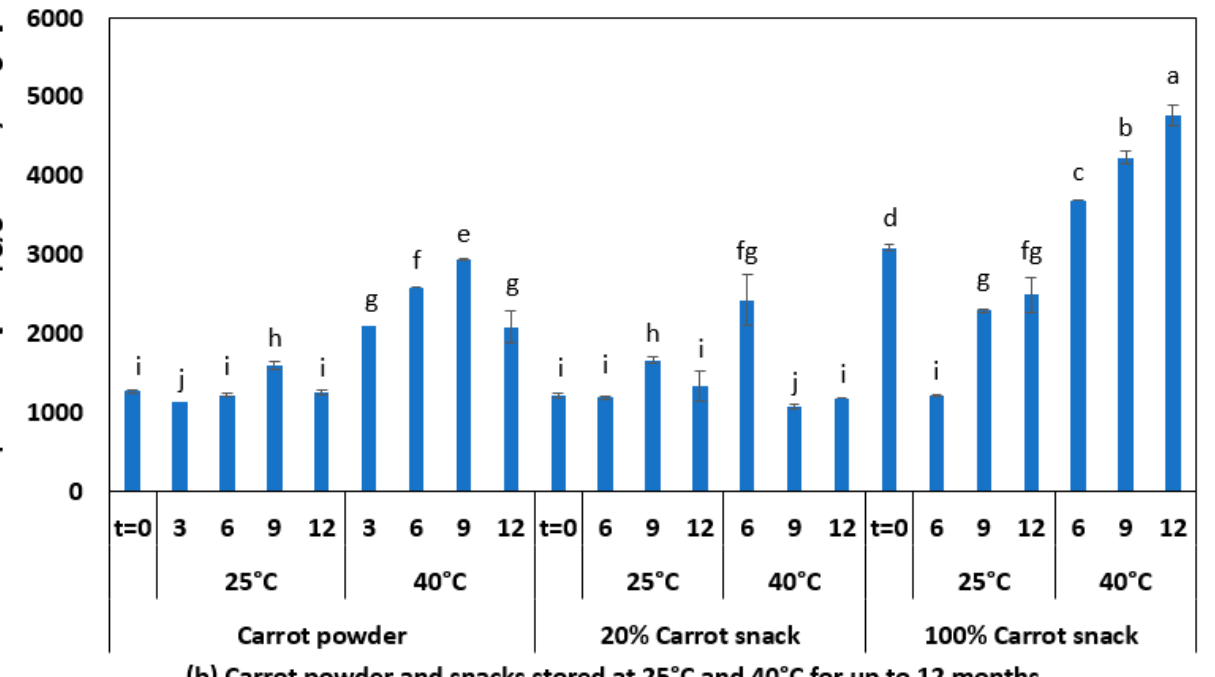
Figure 5. Changes in measured total soluble phenolics during the storage of powders and extrudate: ( a ) Broccoli powder and snacks, ( b ) carrot powder and snacks. Different lowercase letters indicate that there is a significant difference, p < 0.05.